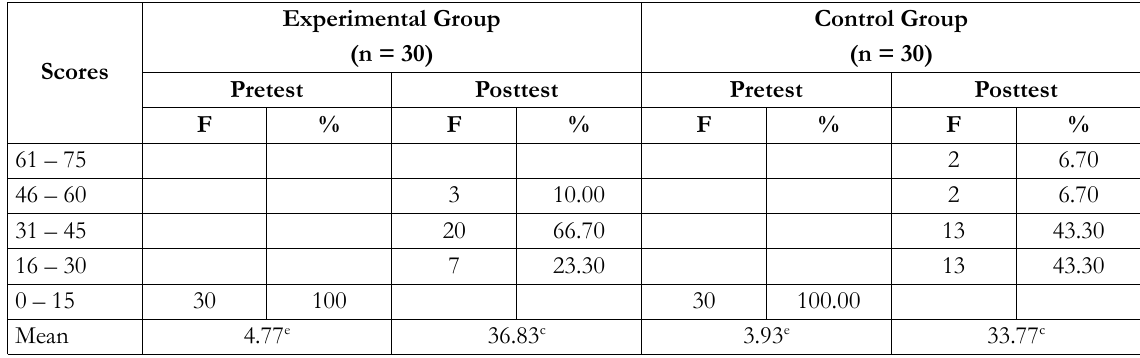
Table 2. Pretest and posttest performances of the participants on procedural